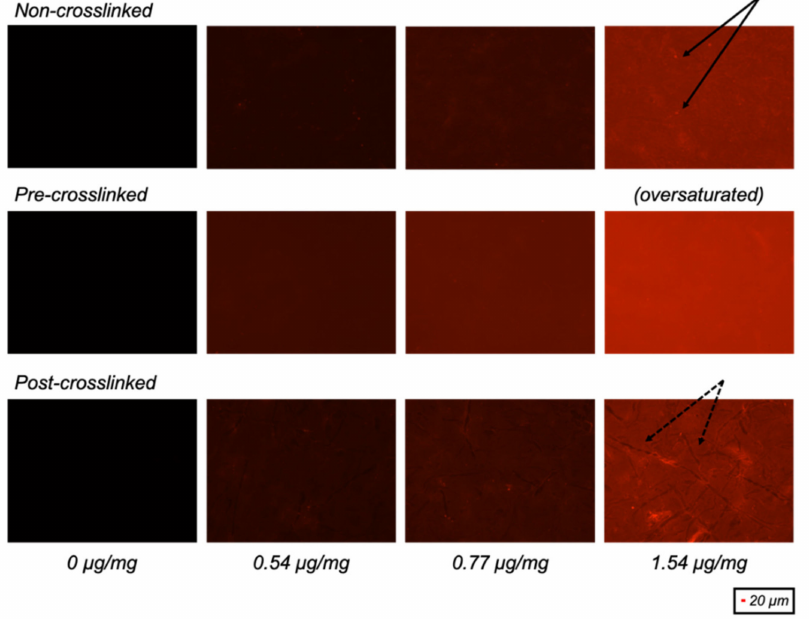
Figure 1. Fluorescence images of non-crosslinked, pre-crosslinked and post-crosslinked collagen films with different quantities of 78% dye-conjugated dendrimer activation ( µ g dendrimer per mg collagen). Presence of overexposed bright particulates (solid) and underexposed collagen “coils” (dashed) are indicated by black